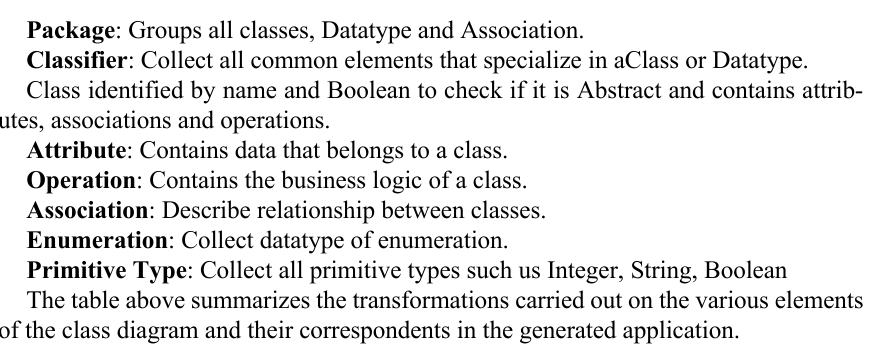
Fig. 3. Our proposed source